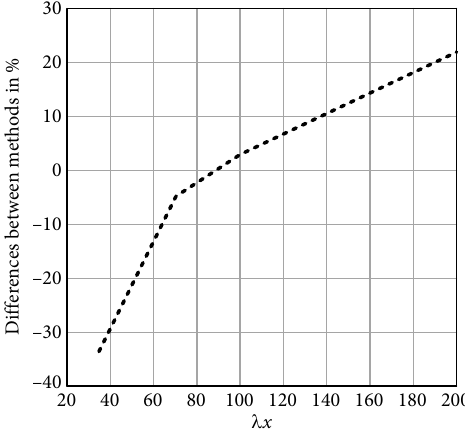
Fig. 9. Difference between the 1 st and 2 nd situation (in-plane). The buckling mode is the general buckling of the built-up column about the main axis. Due to analytical calculation and in accordance with the STR method, this buckling mode is the same (Table